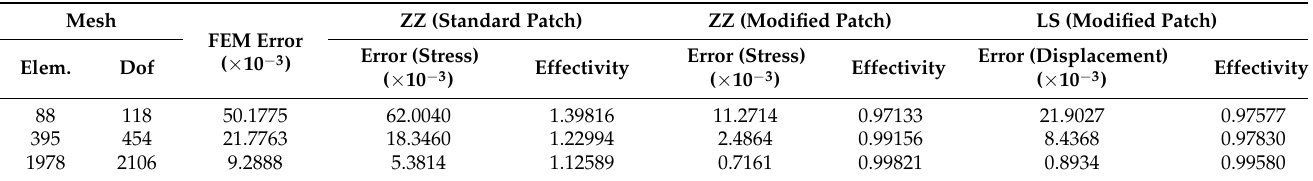
Table 2. Solution error and global effectivity ( θ ) for the plate problem using stress/displacement recovery and patch configuration (irregular linear triangular element).